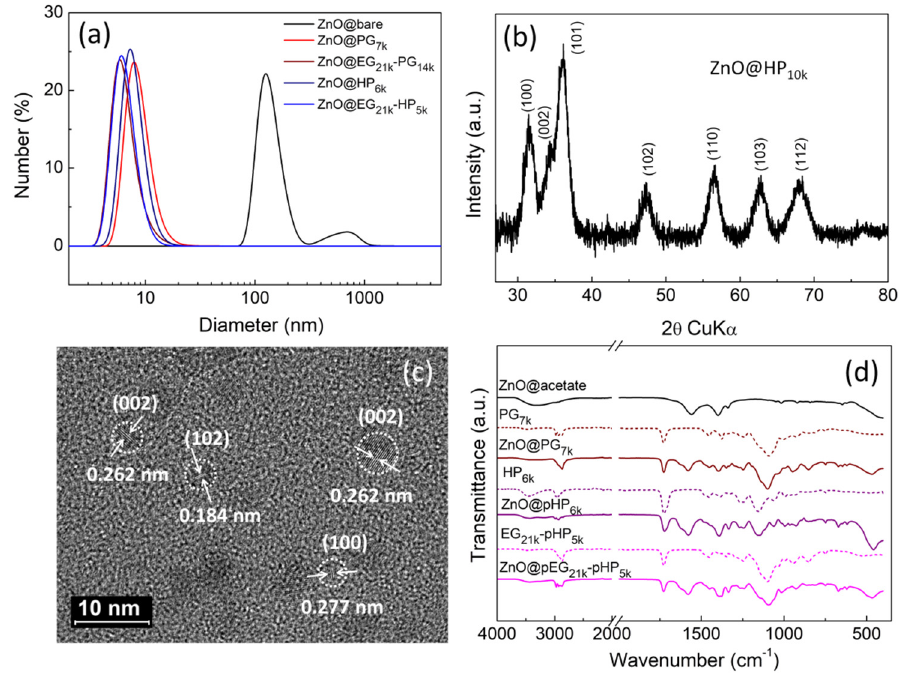
Figure 1. ( a ) Size by number distribution (%) from DLS measurements of the bare ZnO QDs sample and representative hybrid ZnO QDs coated with hydroxylated homopolymers and block copolymers; ( b ) X-ray diffraction patterns corresponding to representative hybrid ZnO QDs showing the wurtzite crystalline structure; ( c ) TEM image corresponding to ZnO QDs synthesized in the presence of HP 7k polymeric coatings; and ( d ) ATR-FTIR spectra corresponding to bare ZnO QDs and representative ZnO QDs coated with hydroxylated homopolymers and block copolymers.